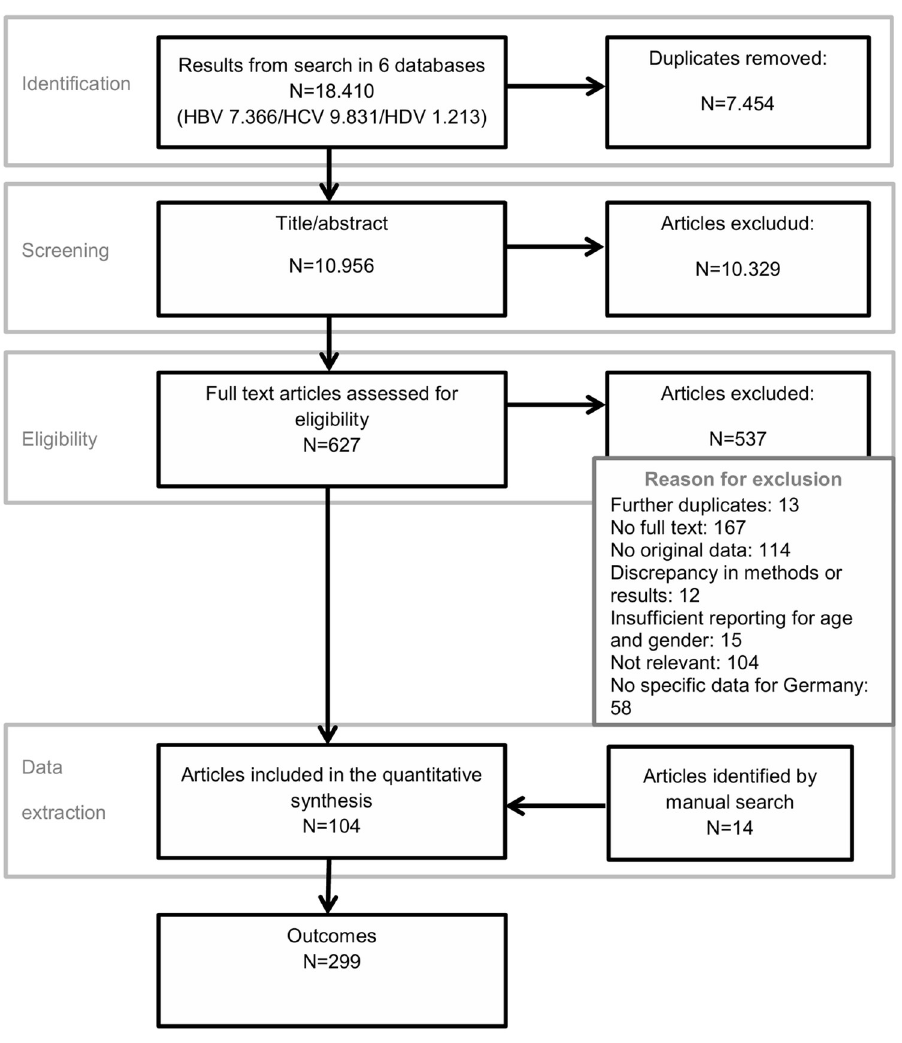
Fig 1. Flow chart of the study